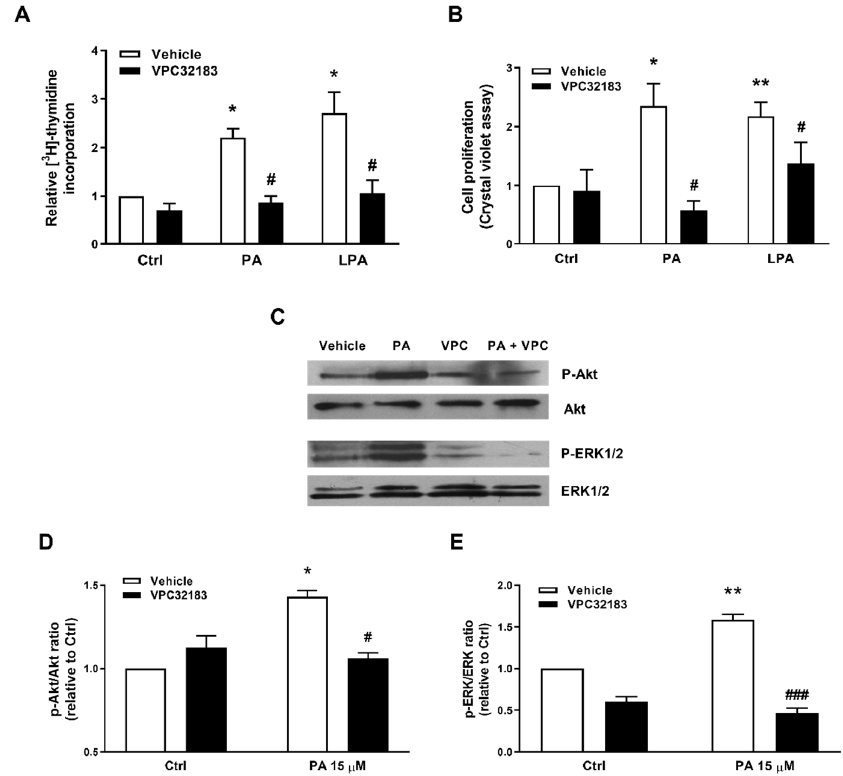
Figure 5. Inhibition of PA-stimulated myoblast proliferation and Akt and ERK1/2 phosphorylation by the lysoPA (LPA) receptor antagonist VPC32183. Myoblasts were serum-starved in DMEM supplemented with 0.1% BSA for 24 h. ( A ) The cells were preincubated for 30 min with 5 µ M VPC32183 and were then challenged with 15 µ M PA or 15 µ M LPA for 16 h, as indicated. [ 3 H]Thymidine incorporation was measured as described in the Materials and Methods section. Results are expressed relative to the control value without agonist and are the mean ± SEM of 3 independent experiments performed in triplicate. (* p < 0.05, control versus PA or LPA-treated cells, # p < 0.05; PA or LPA-treated cells versus PA or LPA-treated cells in the presence of VPC32183). ( B ) Cells were treated as in panel A. Cell proliferation was determined by staining the myoblasts with crystal violet as described in the Materials and Methods section. Results are expressed relative to the control value without agonist and are the mean ± SEM of 3 independent experiments performed. Control versus PA-treated cells; ** p < 0.01, control versus LPA-treated cells; # p < 0.05; PA- or LPA-treated cells versus PA- or LPA-treated cells in the presence of VPC32183). ( C ) Cells were preincubated with 5 µ M VPC32183 for 30 min and then treated with 15 µ M PA for 5 min. Cell lysates were analyzed by western blotting as described in the Materials and Methods section. Phosphorylation of Akt and ERK1/2 was determined using specific antibodies against phospho-Akt (P-Akt) or phospho-ERK1/2 (P-ERK1/2). Equal loading of protein was monitored using specific antibodies to total Akt and total ERK1/2. Panel C shows a representative blot of three independent experiments. ( D , E ) Results of scanning densitometry of the exposed films. Data are expressed as arbitrary units of intensity relative to the control siRNA values in the absence of agonist or inhibitor (Ctrl) and are the mean ± SEM of 3 replicate experiments. (* p < 0.05; ** p < 0.01; control versus PA-treated cells, # p < 0.05, ### p < 0.001; PA-treated cells versus PA-treated cells in the presence of VPC32183, as indicated). In addition, specific siRNA to silence the gene encoding the LPA1 receptor abolished PA-stimulated DNA synthesis, and this was also the case when specific siRNA to silence LPA2 was used (Figure 6A). The silencing of the LPA1 and LPA2 receptors also blocked the phosphorylation of Akt and ERK1-2 (Figure